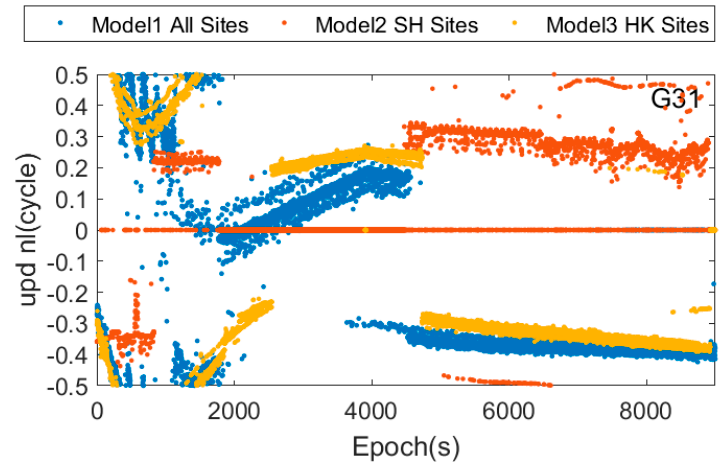
Figure 8. Narrow-lane uncorrected phase delay of G31 in three UPD models.